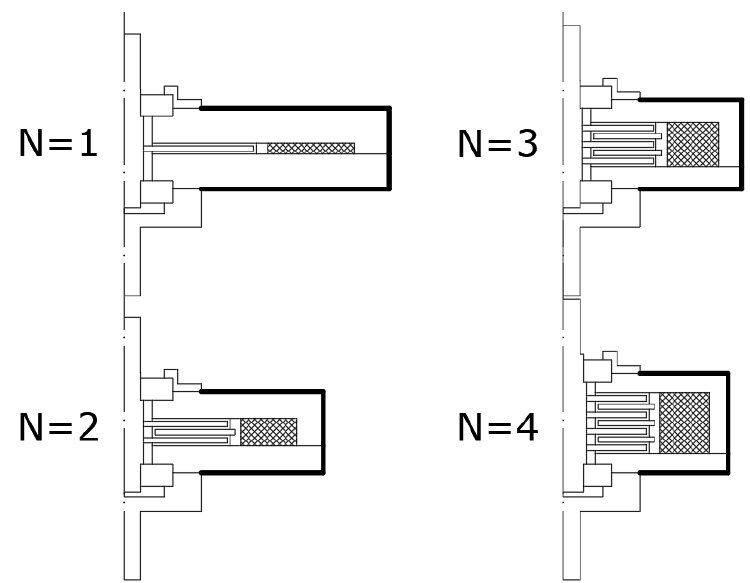
Figure 12. The surface of heat transfer to the environment (surrounding air).